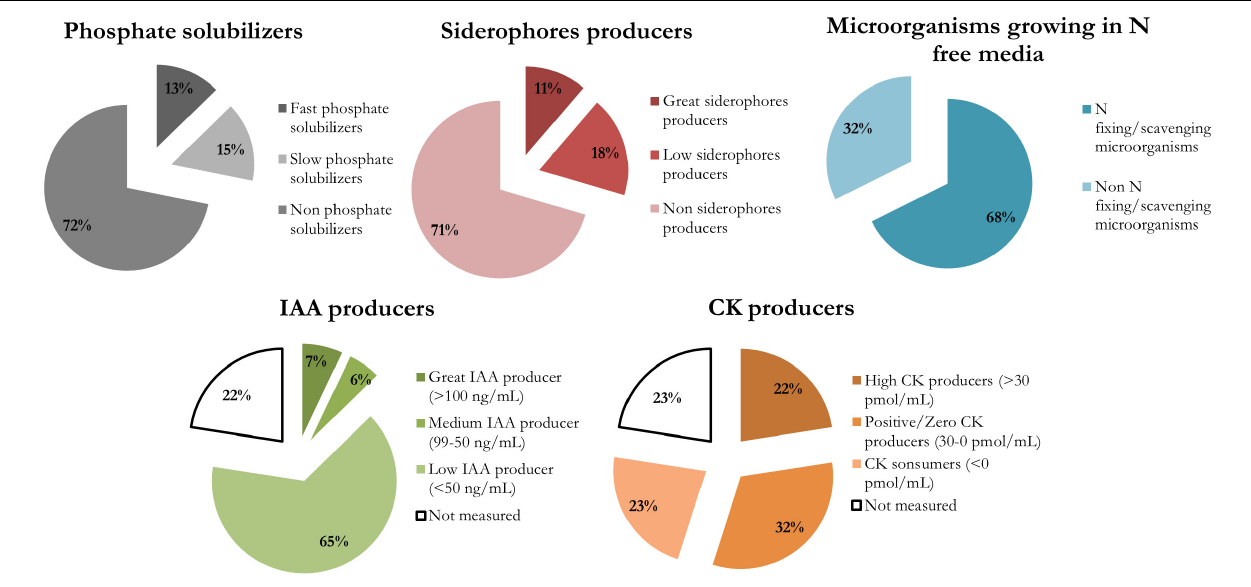
FIGURE 2 | Prevalence of each plant growth promotion trait in the endophytes isolated from cucumber plants pre-treated with a sedimentary humic acid. The traits evaluated were: inorganic phosphate solubilization at 14 days, siderophore production at 7 days, capability of growing in a N-free medium, and phytohormones production (IAA and CKs).